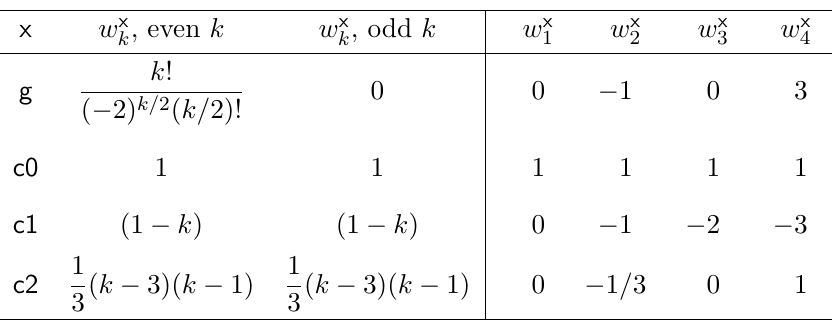
entering the small- (cid:15) expansion in k and w c2 are the lowest non-zero 3 5